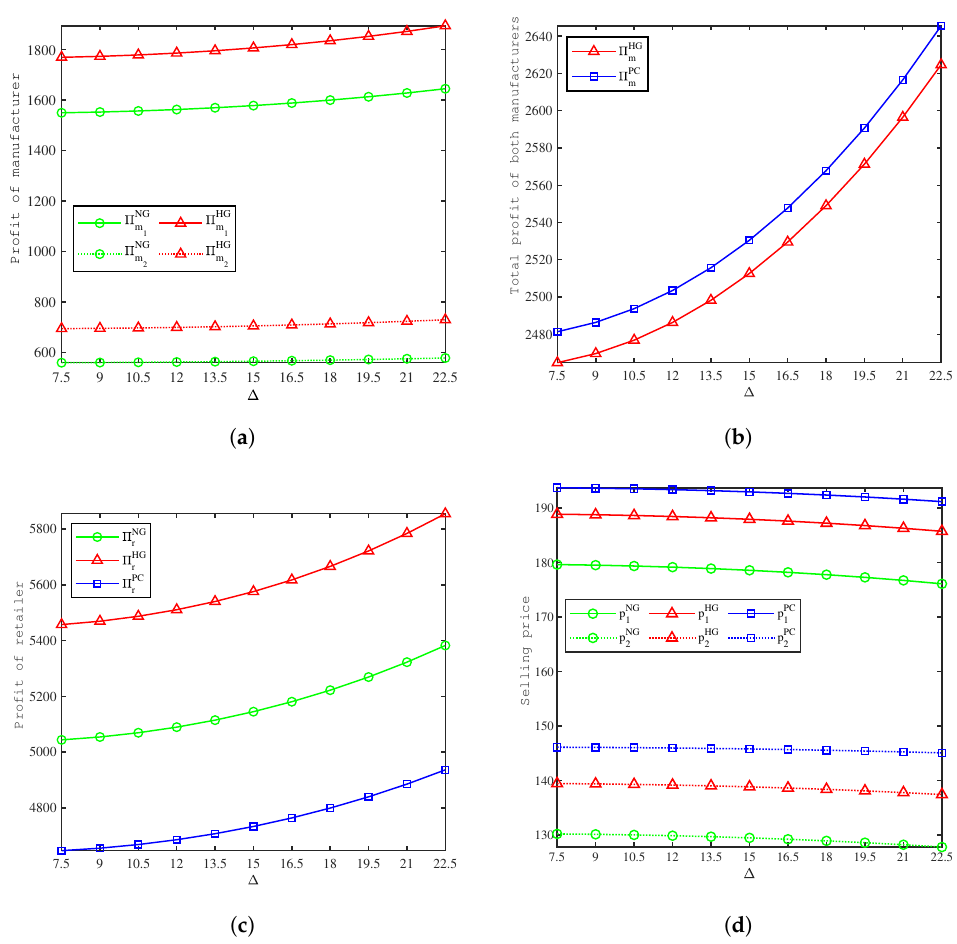
Figure 4. Comparison of the profit between models. ( a ) Effects of ∆ on the manufacturers’ profits. ( b ) Effects of ∆ on the manufacturers’ total profits. ( c ) Effects of ∆ on the retailer’s profits. ( d ) Effects of ∆ on the selling